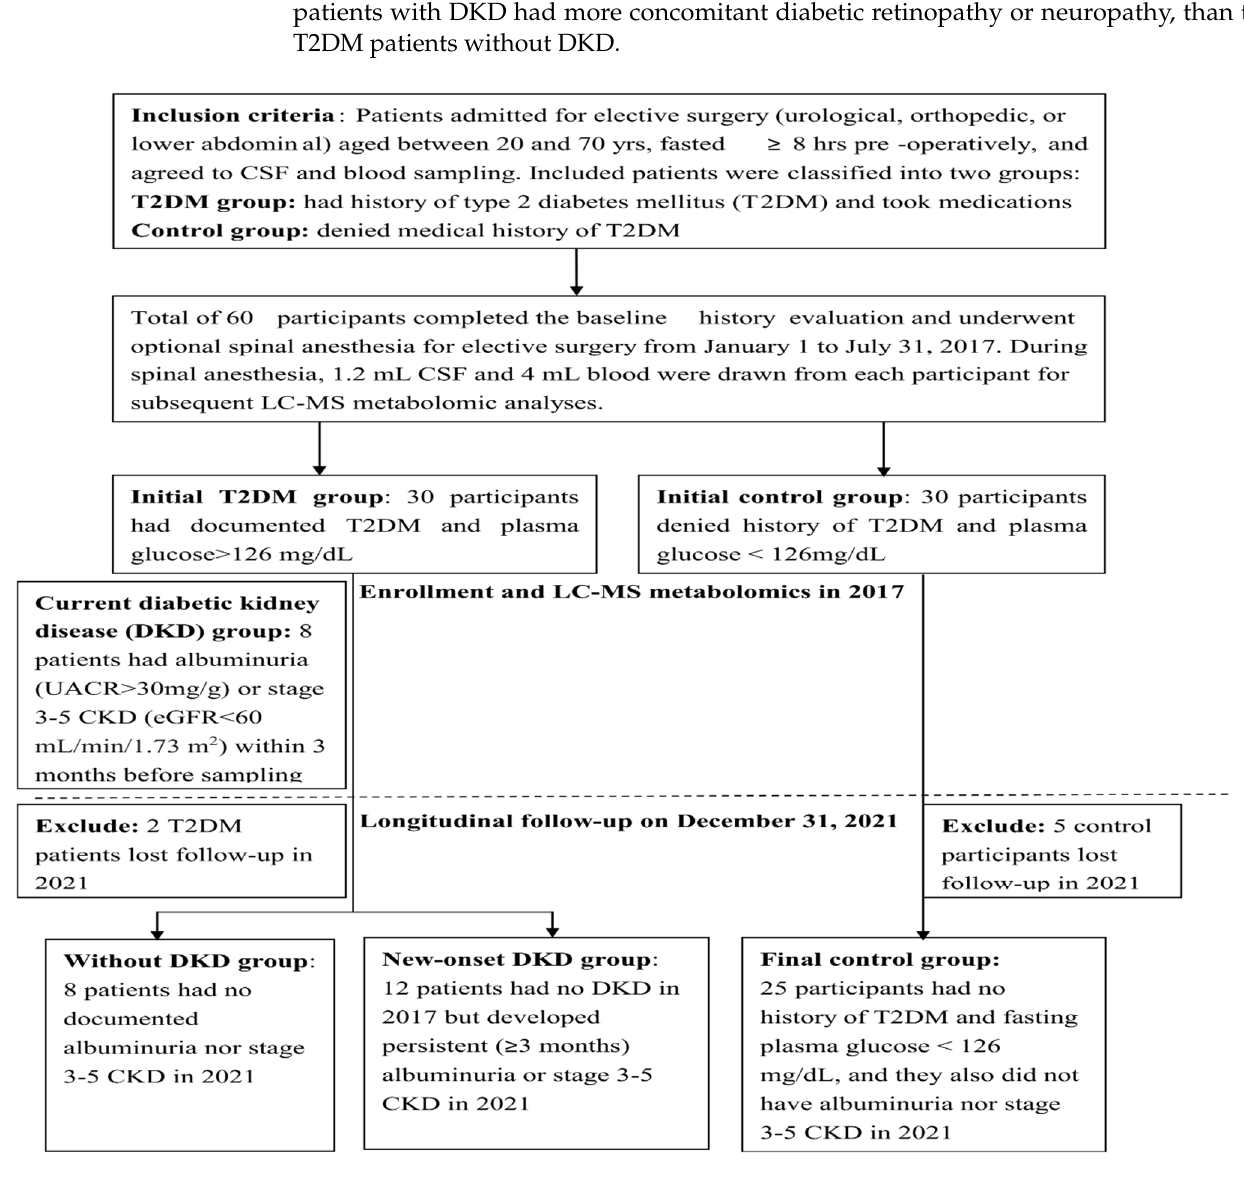
Figure 1. Flow chart for the study design and group separation. Table 1. Demographic comparison between the type 2 diabetic patients with or without diabetic kidney disease and the control participants.